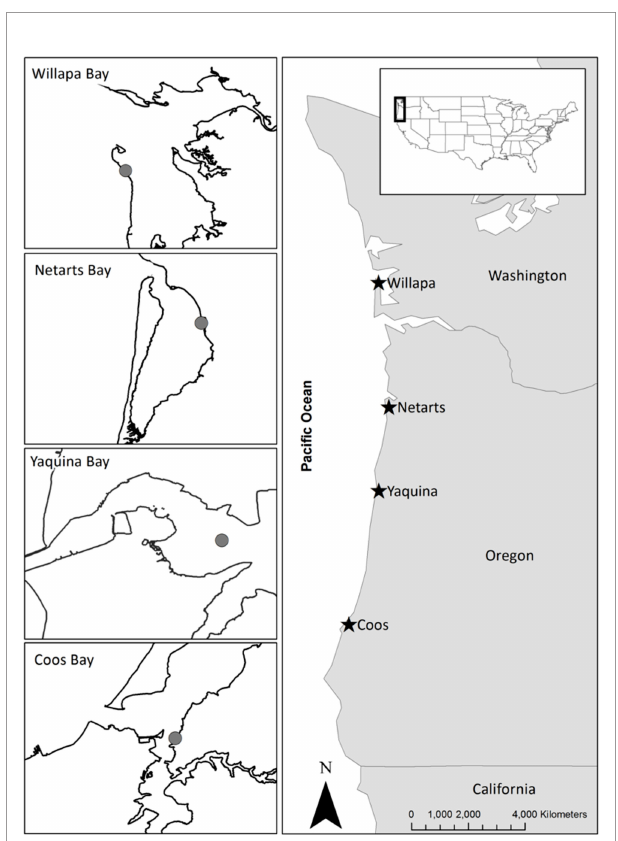
FIGURE 1 | Map of the study sites in four estuaries of the US Paci fi c Northwest coast, including Willapa Bay, Washington and Netarts Bay, Yaquina Bay, and Coos Bay, Oregon. Gray circles on each inset map indicate the location of macrophyte sampling. Site locations and characteristics are given in Appendix A : Tables S1 , S3